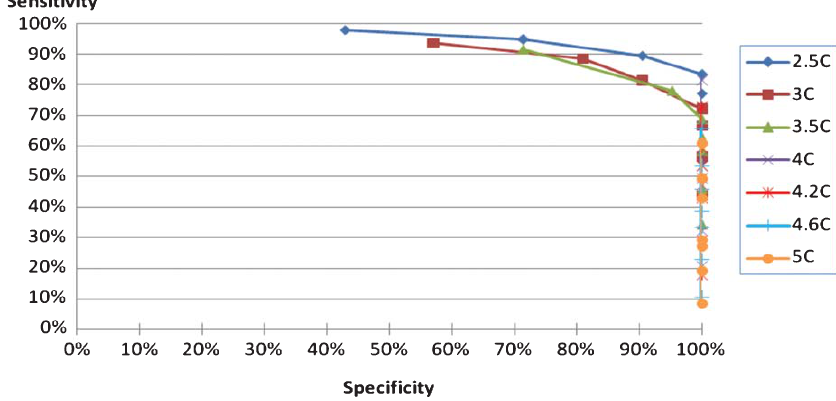
Fig. 2. The sensitivity and specificity of diagnosis of effusion by DNA ploidy, expressed as DNA ploidy index and numbers of cells exceeding such index. DNA ploidy index ranges g from 2.5c to 5c and cell numbers ranges from 1 to 4. Based on Youden Index, the point (4 cells and 2.5c) is at the right corner of the coordinate, which means this is the most optimal cut-off point for DNA ploidy diagnosis of effusions in this